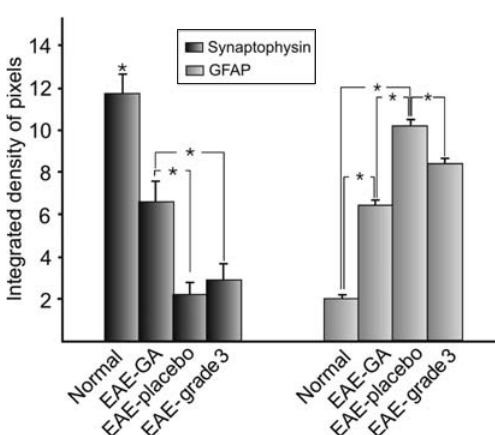
Figure 3. Photomicro- graphs obtained at the level of the spinal cord ventral horn (L4-L5) showing the correlation between demy- elination/inflammation and the clinical scores for EAE. Panels A-D, Sudan black staining at the level of the ventral horn of the spinal cord showing the degree of myelination in normal (A), EAE-GA (peak of the dis- ease after treatment, B), EAE-placebo (C) and EAE- grade 3 (D) animals. Note that GA preserved a signifi- cant degree of myelination (dashed circle in B). The pla- cebo-treated and untreated material showed evident signs of demyelination (dashed circles in C and D, respectively). Panels E-H, Toluidine blue-stained semi- thin sections obtained from the different experimental situations. Normal (E), EAE- GA (F), EAE-placebo (G), and EAE-grade 3 (H). Ob-